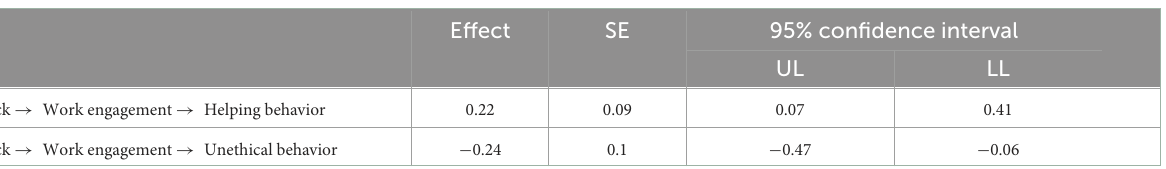
FIGURE4 Results for the model. * p < 0.05 and ** p < 0.01.